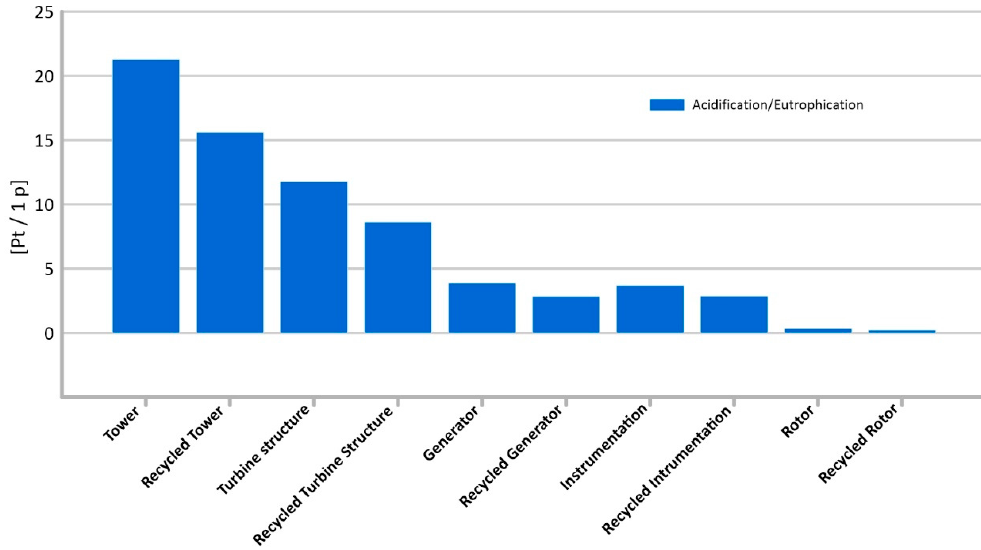
Figure 13. Results of grouping and weighting—Acidification/Eutrophication.